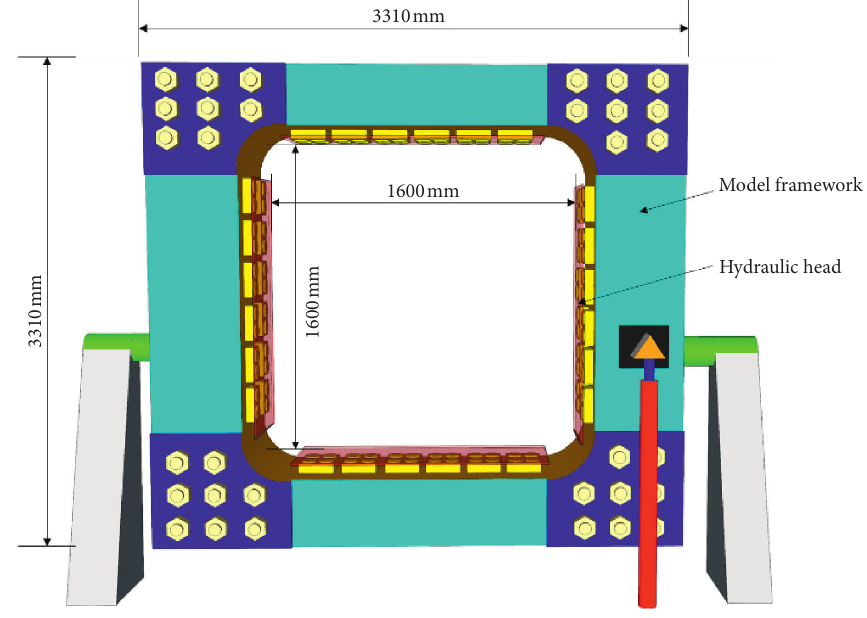
Figure 3: Plane strain loading experiment